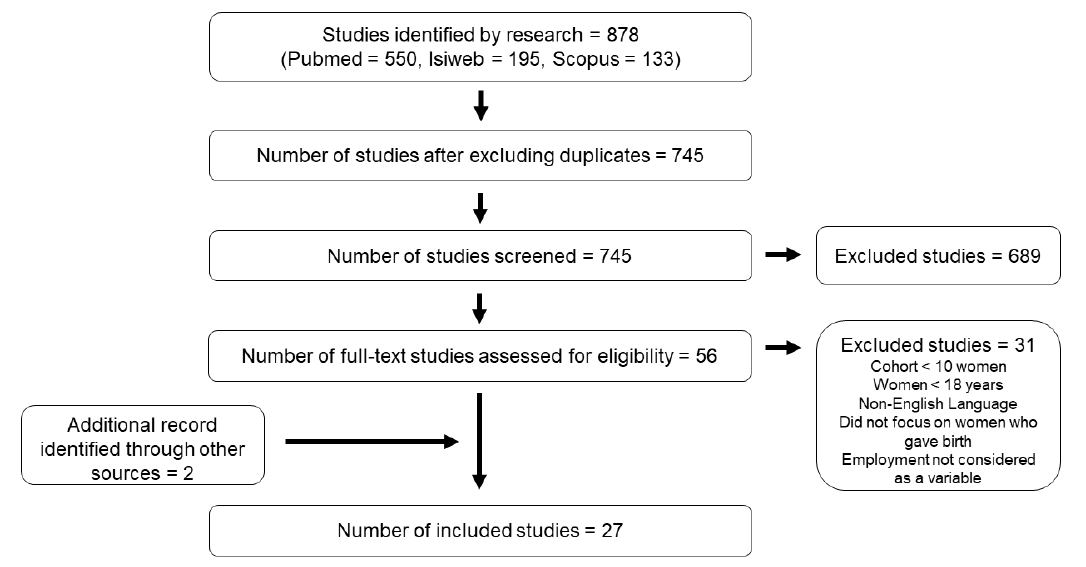
Figure 1. Flow diagram of literature research.